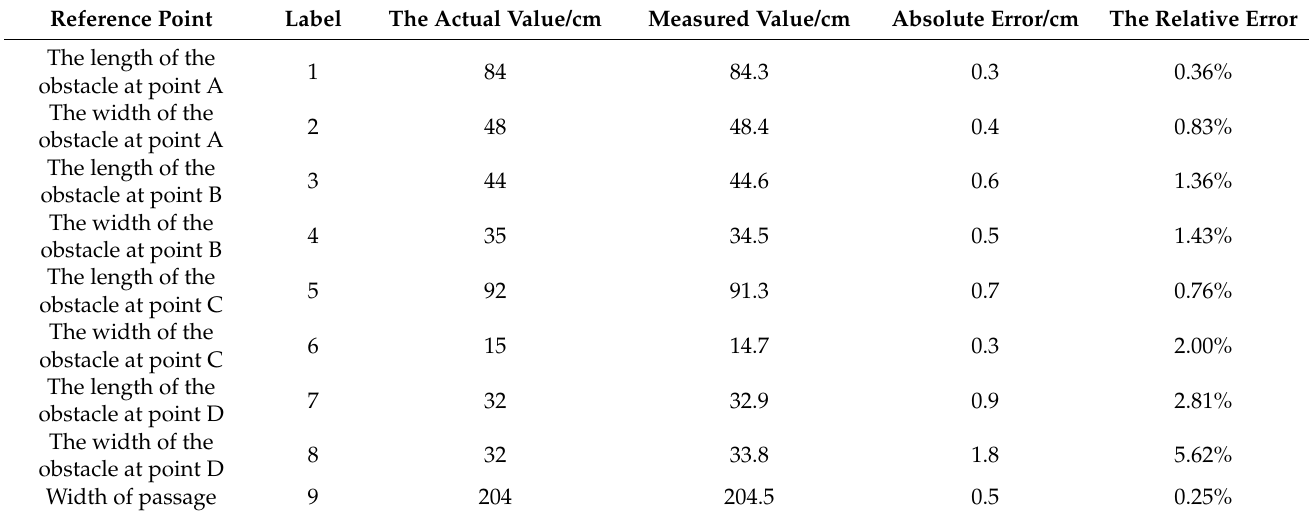
Table 12. Measurement data with a particle count of 60 (with 2.0 kg